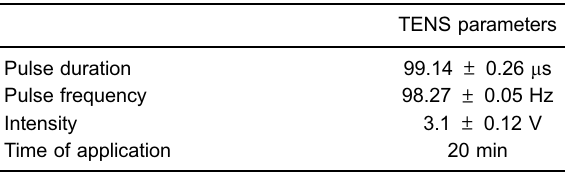
Table 2. Parameters for application of transcutaneous electrical nerve stimulation